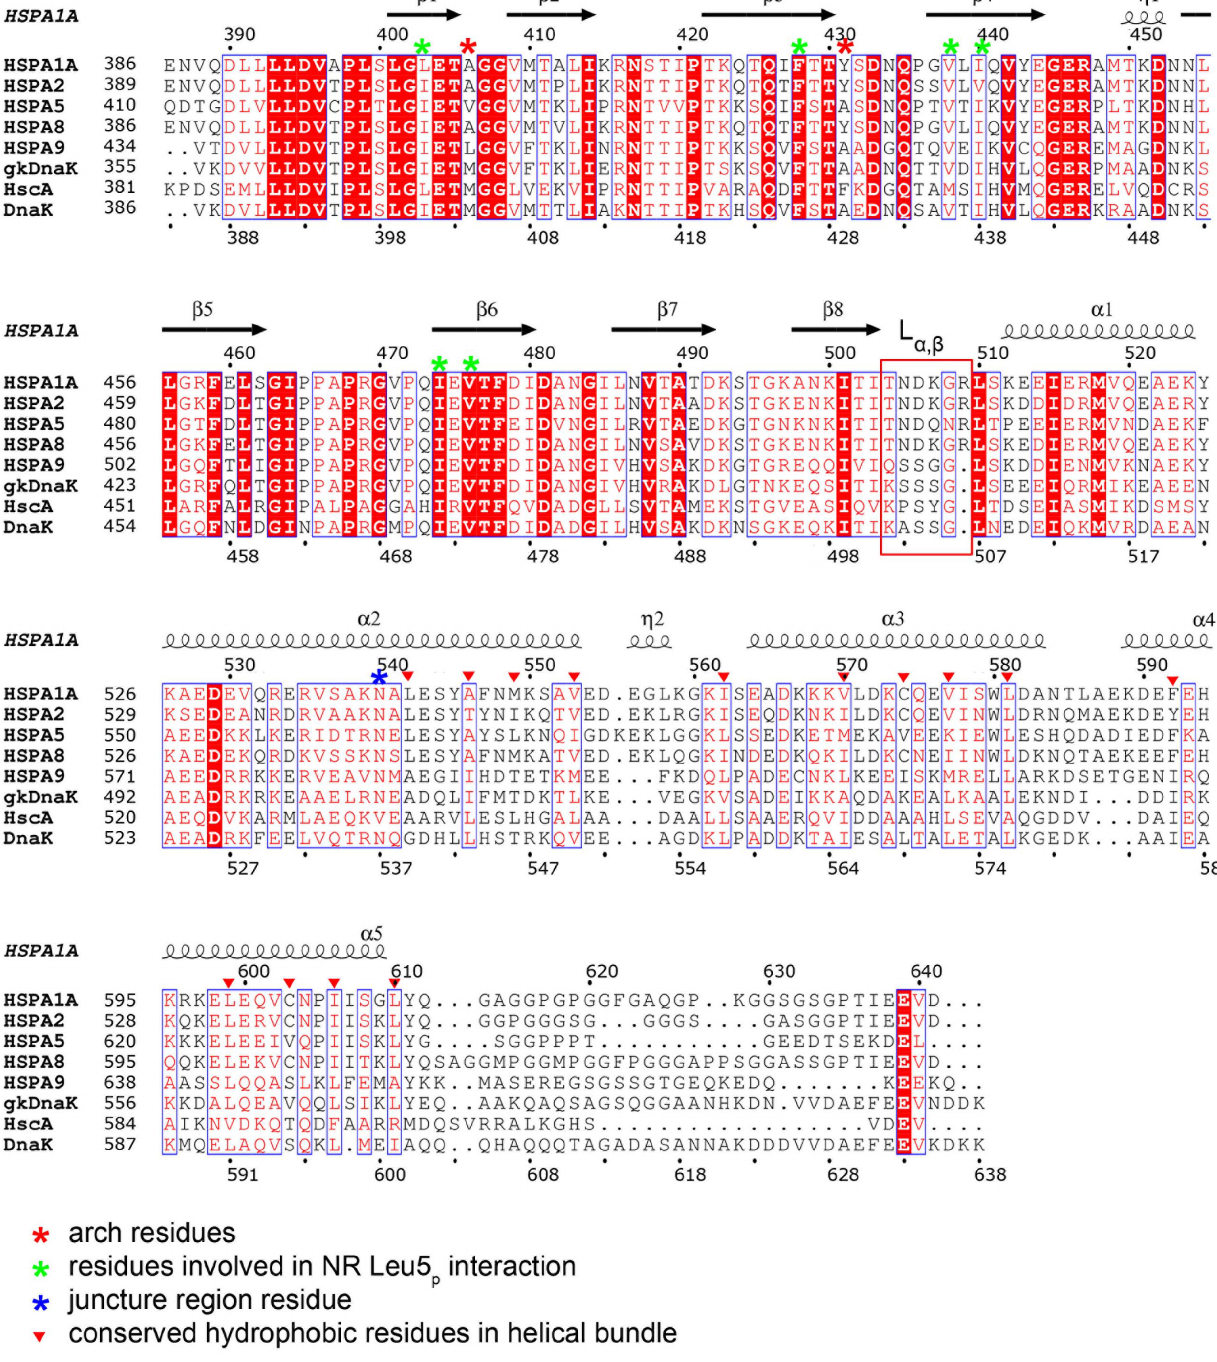
Figure 2. Sequence alignment of eukaryotic and bacterial HSP70 proteins. Human HSP70 (HSPA1A or HSP72), HSPA2, HSPA5 (GRP78 or BiP), HSC70 (HSPA8 or HSP73), HSPA9 (GRP75, Mortalin-2 or MTHSP70) and E.coli DnaK (ecDnaK), E. coli HscA, Geobacillus kaustophilus HTA426 DnaK (gkDnaK) sequences are used for the alignment. Secondary structure elements and residue numbering for HSP70 is indicated above the protein sequence. The hinge region (also known as loop L a , b ) is highlighted in a red rectangular box, the arch residues are indicated with red asterisks, residues involved in NRLLLTG Leu5 p substrate binding are indicated with green asterisks, and the juncture region residue Asn540 is indicated with a blue asterisk. The conserved hydrophobic residues in the helical bundle region are indicated with red triangles. doi:10.1371/journal.pone.0103518.g002 the C-terminal part of helix a B and the associated helical bundle ingly, DnaK shows a more extensive network of interactions region of the SBD a subdomain to take on more divergent between residues within helix a B and the SBD b subdomain. This is consistent with the greater degree of structural and functional positions when compared to different HSP70 proteins. Interest-